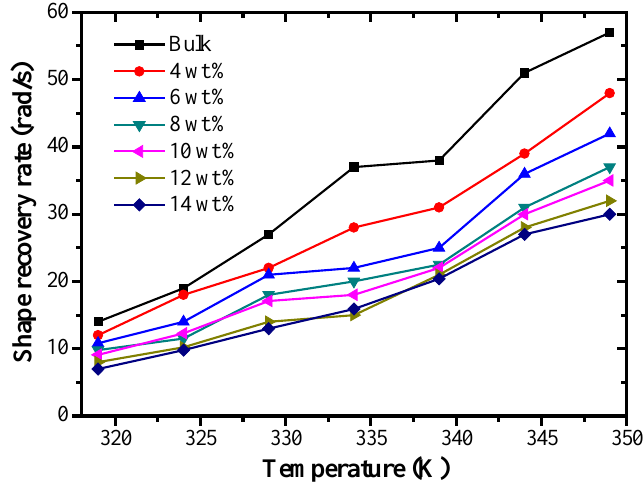
Fig. 19. The shape recovery rate of shape memory polymer composites with different chopped Figure 19. The shape recovery rate of SMP composites with different chopped carbon fiber contents under different carbon fiber content under different temperatures.